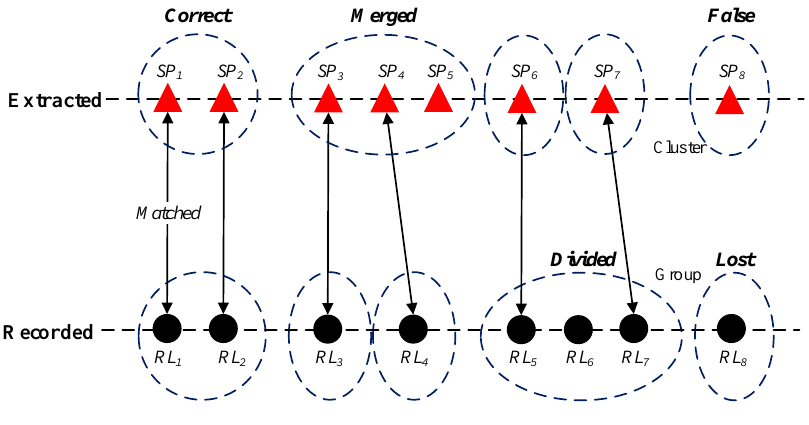
Figure 12. An example of evaluation metrics. Table 4. Comparison with the density-based algorithm.